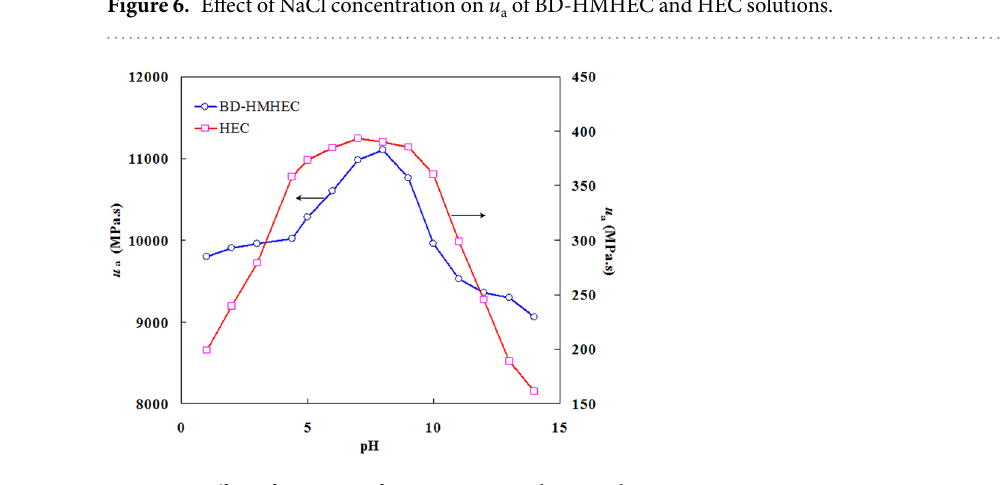
Figure 6. Effect of NaCl concentration on u a of BD-HMHEC and HEC solutions.